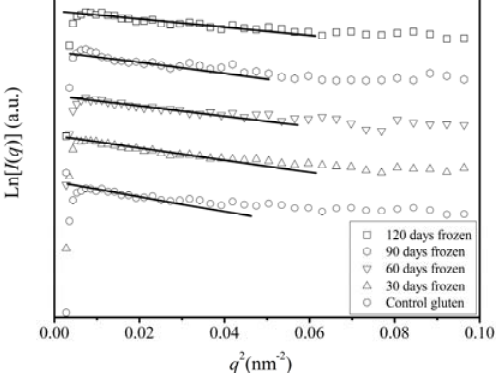
Figure 1. Guinier plots scattering curves from various frozen storage time states of gluten.